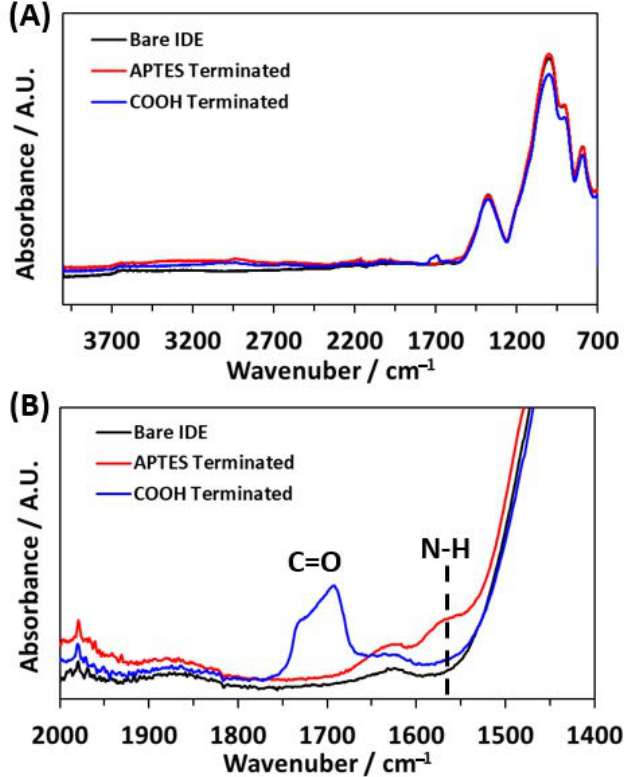
Figure 1. Infrared spectra for the bare IDE, IDE after silane functionalization, IDE after succinic anhydride functionalization. ( A ) full IR spectra; ( B ) zoomed in to 1400–2000 cm − 1 to highlight peaks formed after functionalization with aminosilanes (N–H peak at 1560 cm − 1 ) and succinic anhydride (C=O peak at 1690 cm − 1 ).